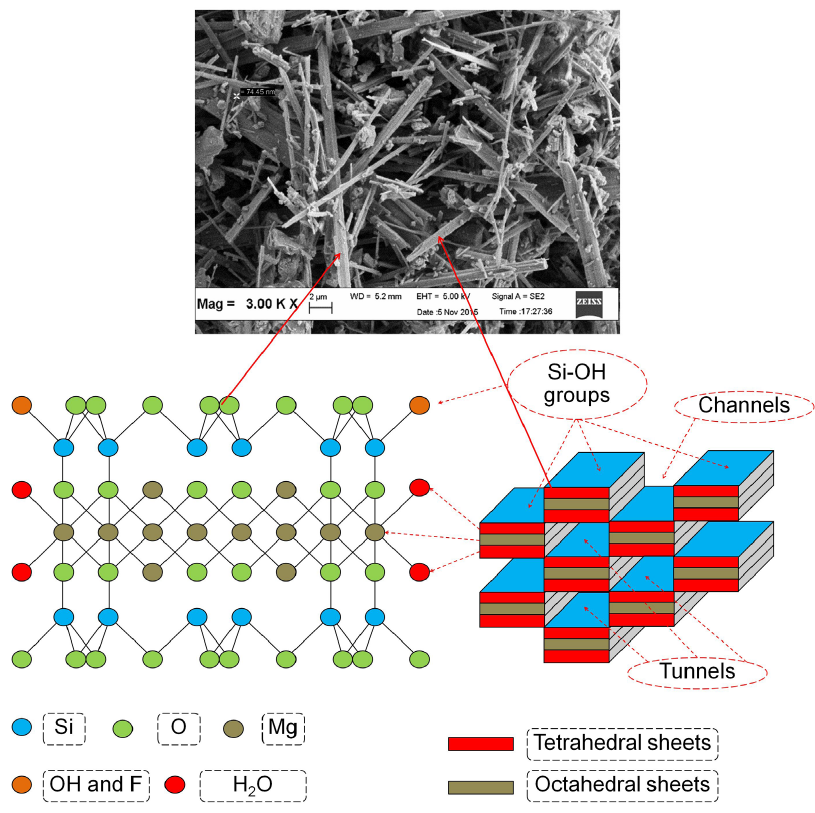
Figure 1. Sepiolite shape and